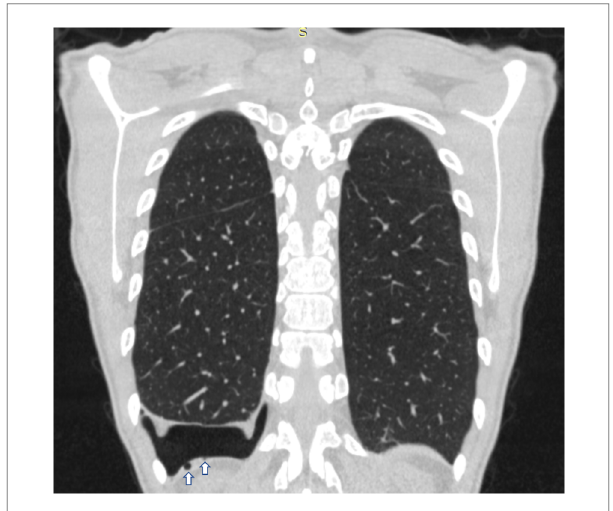
FIGURE 2 Coronal chest CT scan of a patient with CP showing on the right side small diaphragmatic defects, called “ air- fi lled bubble ” perforations (indicated by white arrows). CT, computed tomography; CP, catamenial pneumothorax.